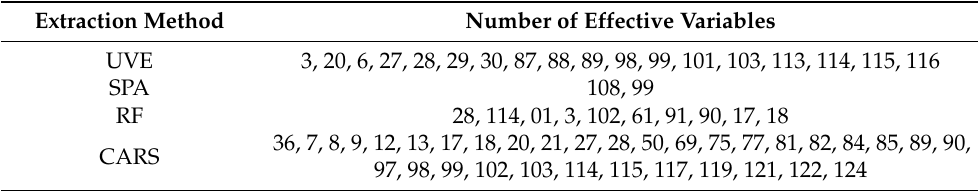
Table 3. Results of two diversity methods and five preprocessing